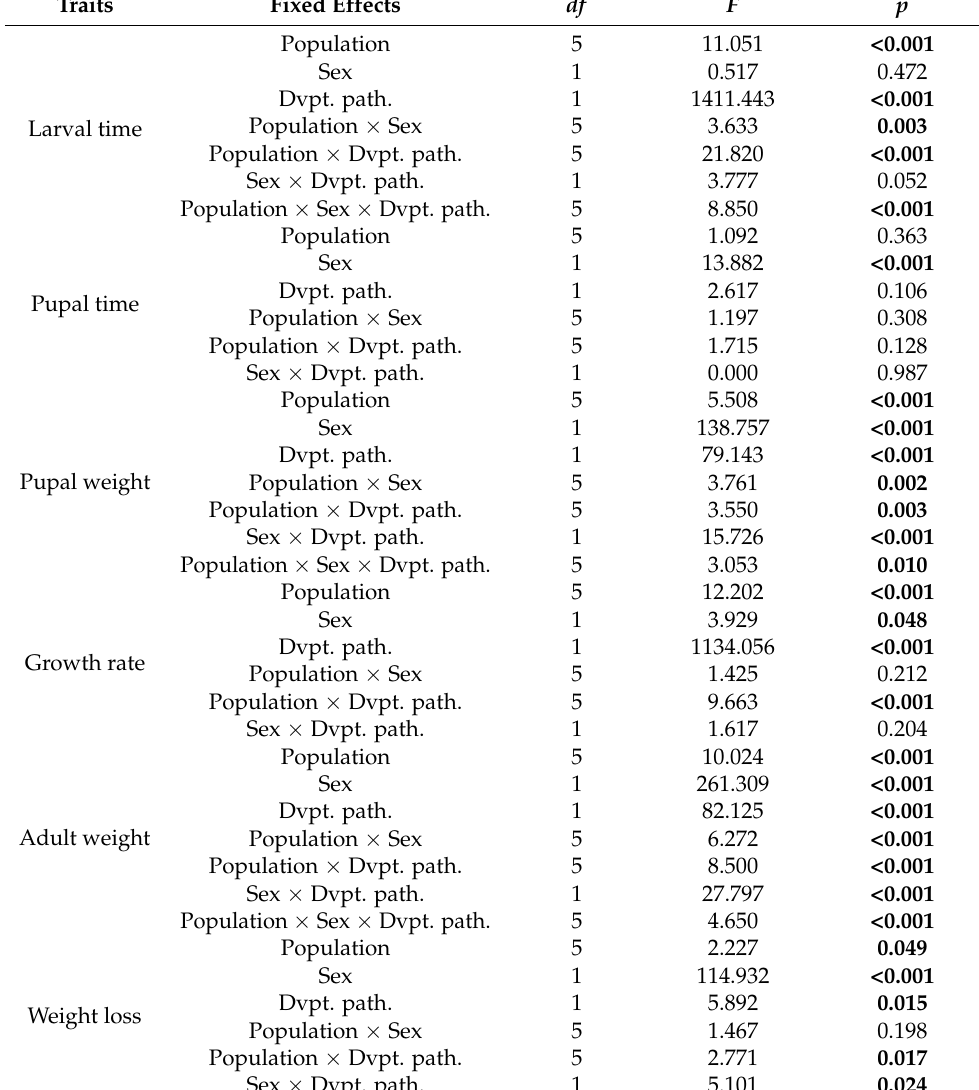
Table 2. The results of the linear mixed model analyses of larval time, pupal time, pupal weight, growth rate, adult weight and weight loss of Ostrinia furnacalis depended on population, sex, and development pathway (dvpt.